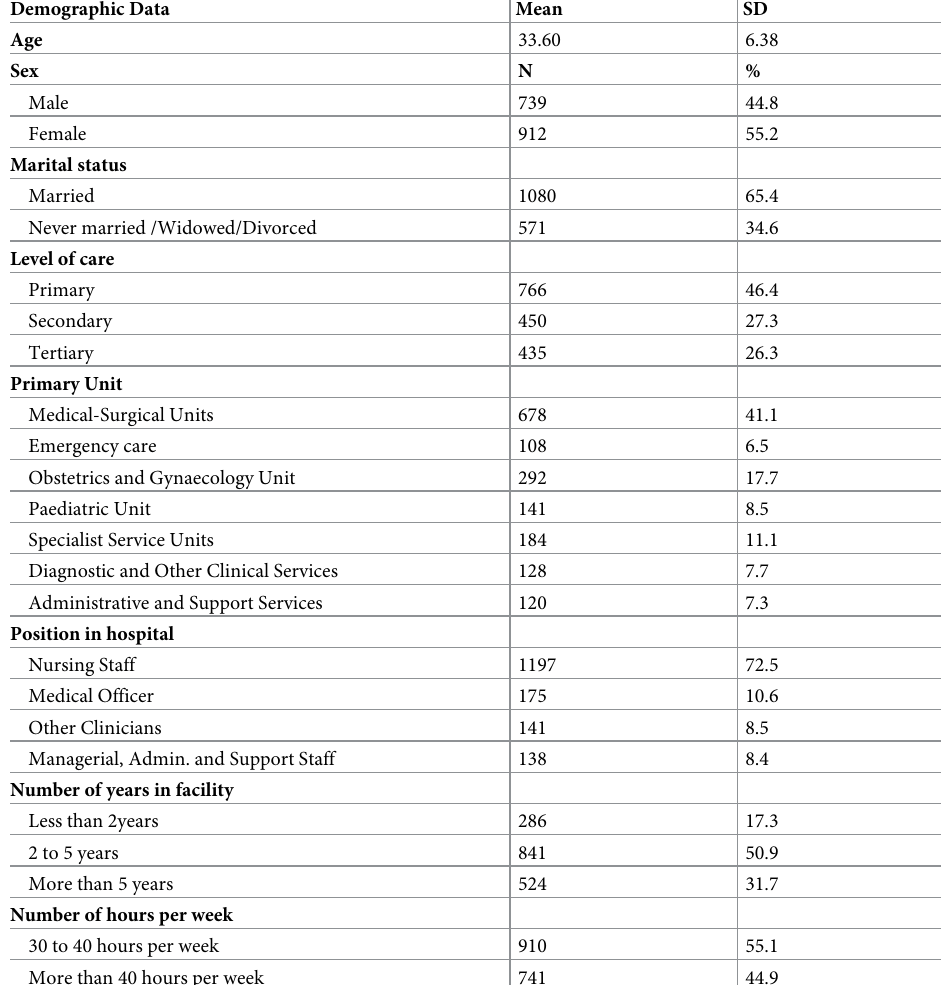
Table 1. Socio-demographic data of participants and hospital characteristics. Demographic